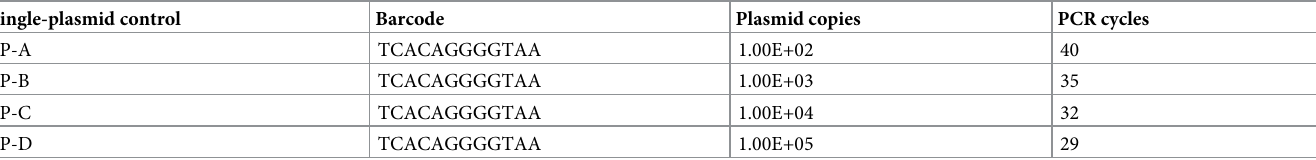
Table 1. Single-plasmid controls preparation. Single-plasmid control